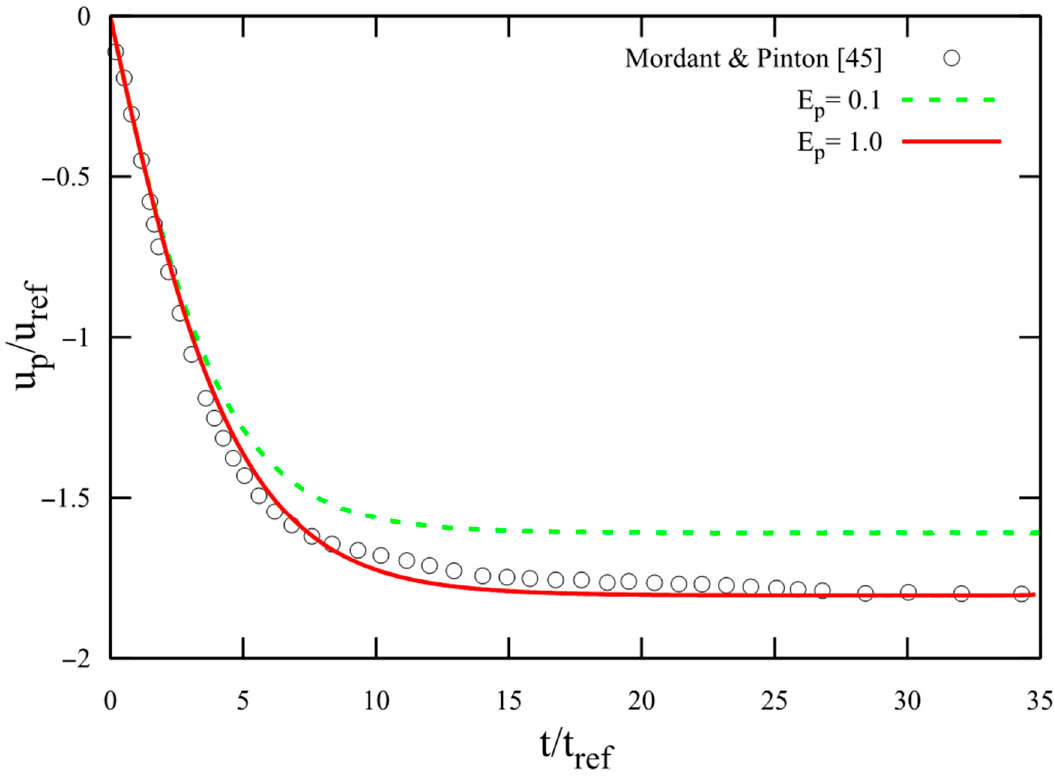
Figure 11. Influence for of several particle volume expansion coe ffi cients when using an integrated added mass coe ffi cient of